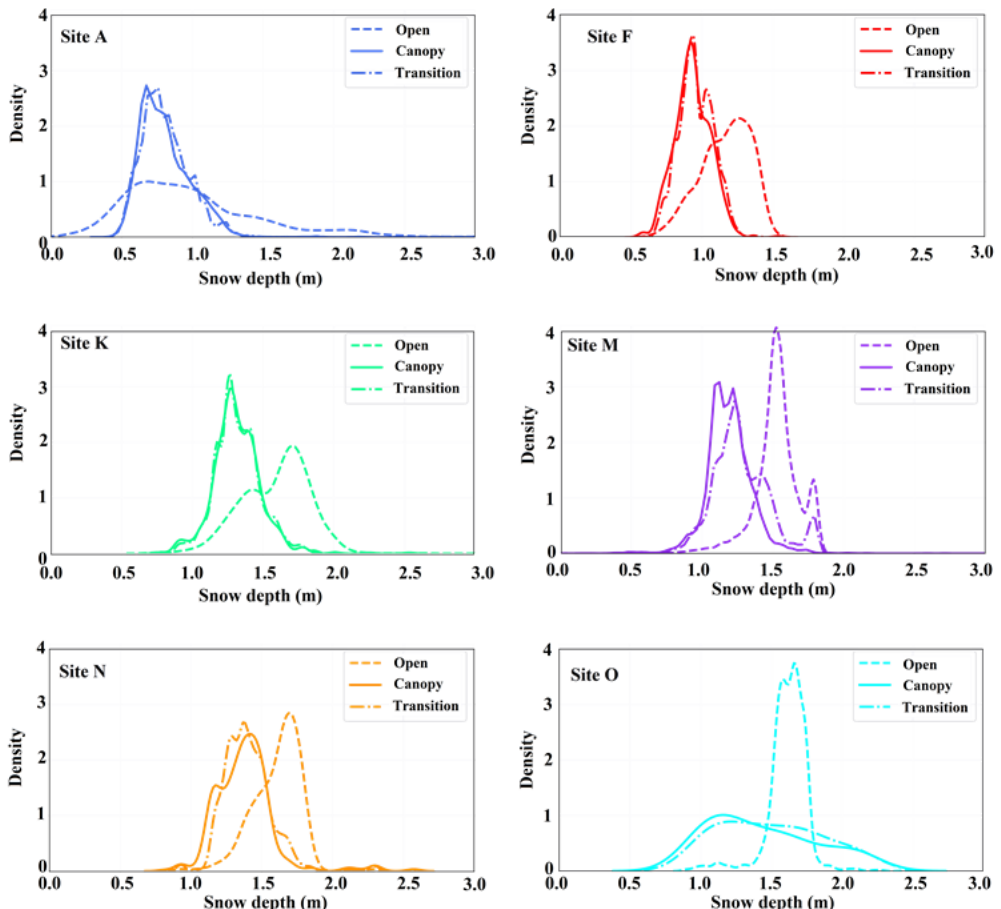
Figure 6. Snow depth under the canopy, within the 10m transition zone, and in the open.